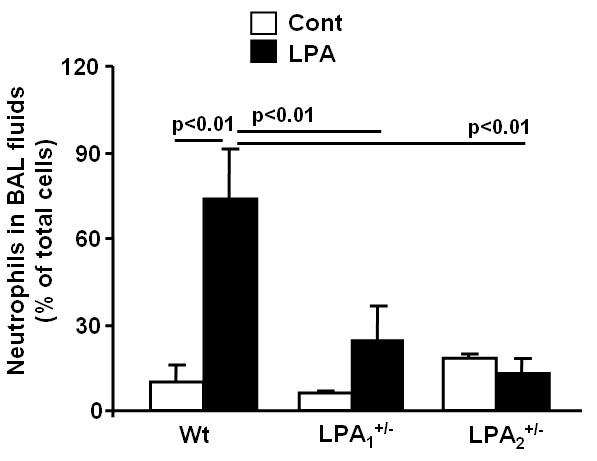
LPA1+/- and LPA2+/- mice show reduced neutrophils infiltration to BAL fluids. 18:1LPA (5 μM in 25 μl PBS) were intratracheally injected to wild type, LPA1+/-, and LPA2+/- mice (n = 4-5) for 6 h. BAL fluids were collected and percentage of neutrophils in total cells were examined by Cytospin.